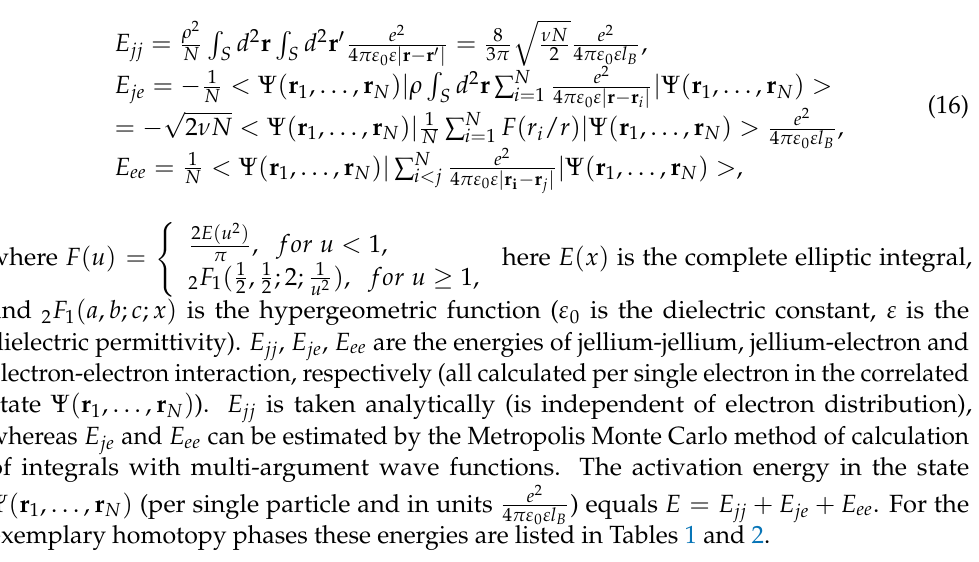
Table 1. Activation energy for exemplary homotopy pattern { x i } = ( 1,1,2 ) for ν = 2 correlations of CF type (with q = 3 and x 1 = x 2 = 1 and x 3 = 2). Energy